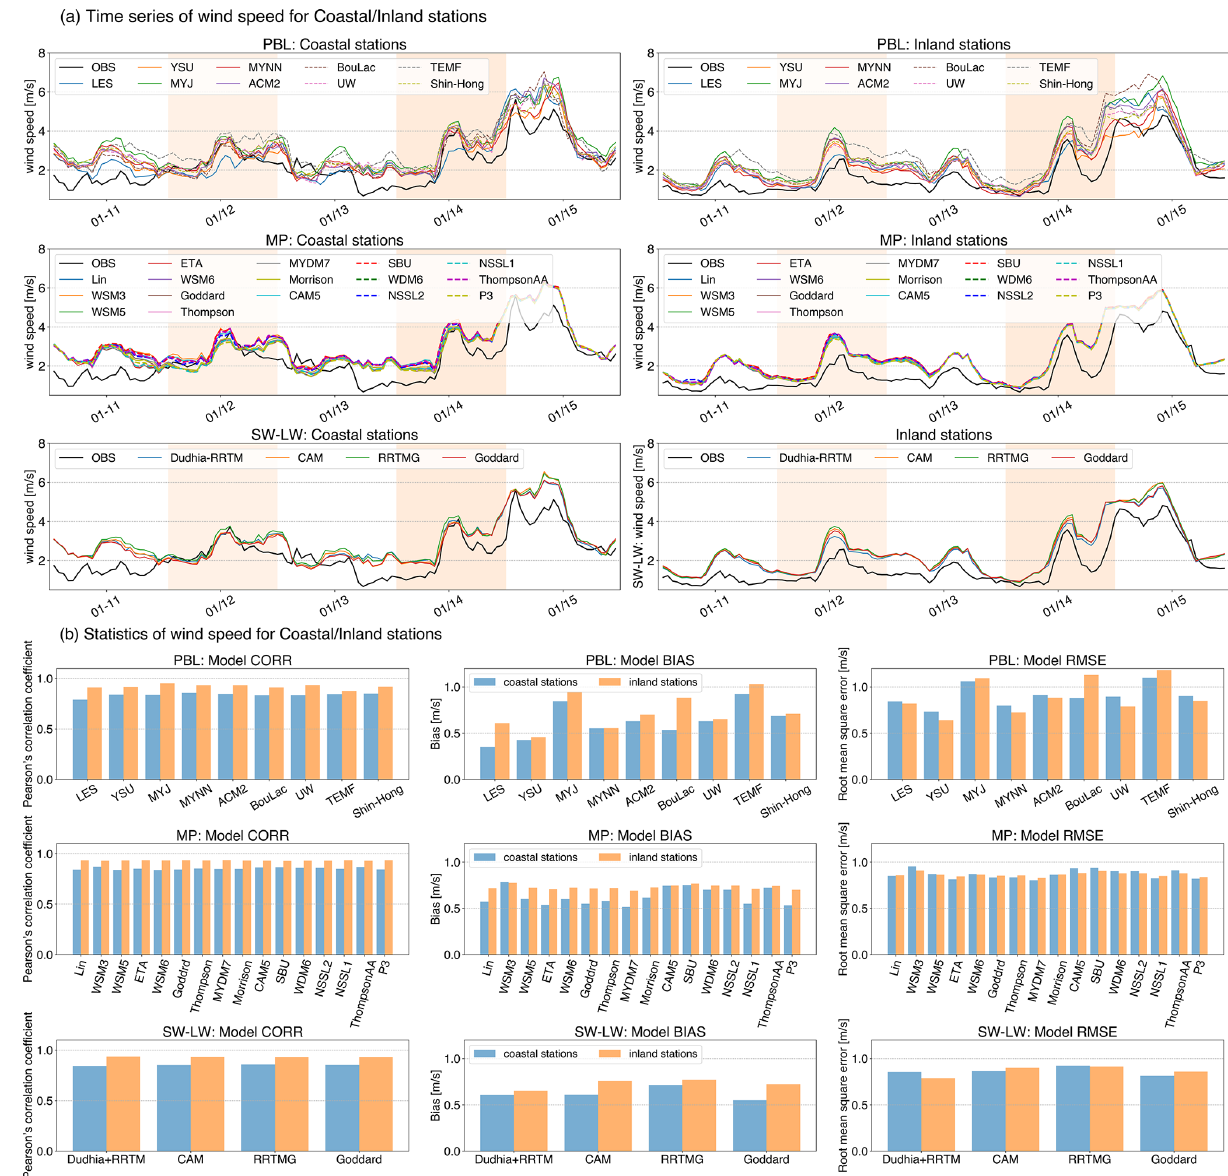
Figure 11. Comparison of simulated wind speeds between the coastal and inland stations shown in Fig. 1a as well as the corresponding statistical